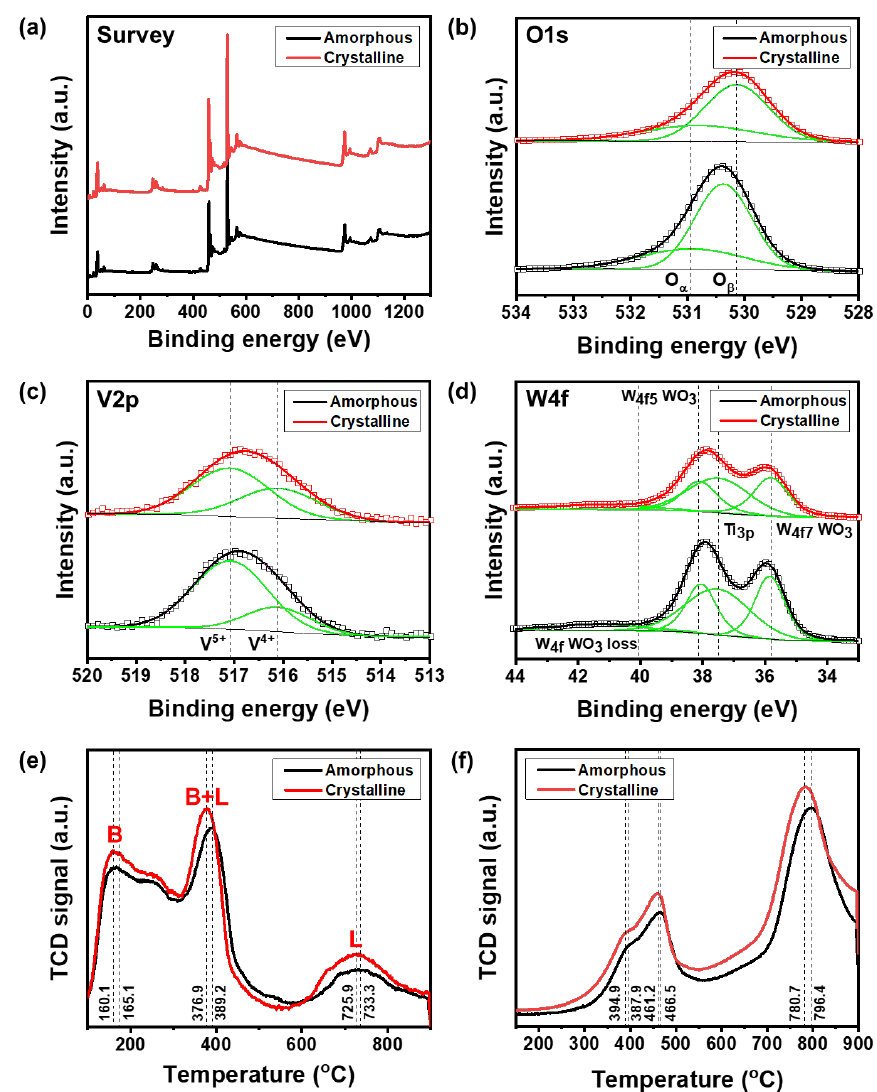
Figure 5. XPS spectra for ( a ) survey, ( b ) O1s, ( c ) V2p, and ( d ) W4f of amorphous V 2 O 5 -WO 3 /TiO 2 and crystalline V 2 O 5 -WO 3 /TiO 2 ( e ) NH 3 -TPD profiles of amorphous V 2 O 5 -WO 3 /TiO 2 and crystalline V 2 O 5 -WO 3 /TiO 2 . B and L indicate Brønsted and Lewis acid sites, respectively. ( f ) H 2 -TPR profiles of amorphous V 2 O 5 -WO 3 /TiO 2 and crystalline V 2 O 5 -WO 3 /TiO 2 . Table 3. The ratio of Oα , V 4+ of amorphous and crystalline V 2 O 5 -WO 3 /TiO 2 measured by XPS, NH 3 -temperature-programmed desorption and H 2 -temperature-programmed reduction integral intensity of amorphous and crystalline V 2 O 5 -WO 3 /TiO 2 .